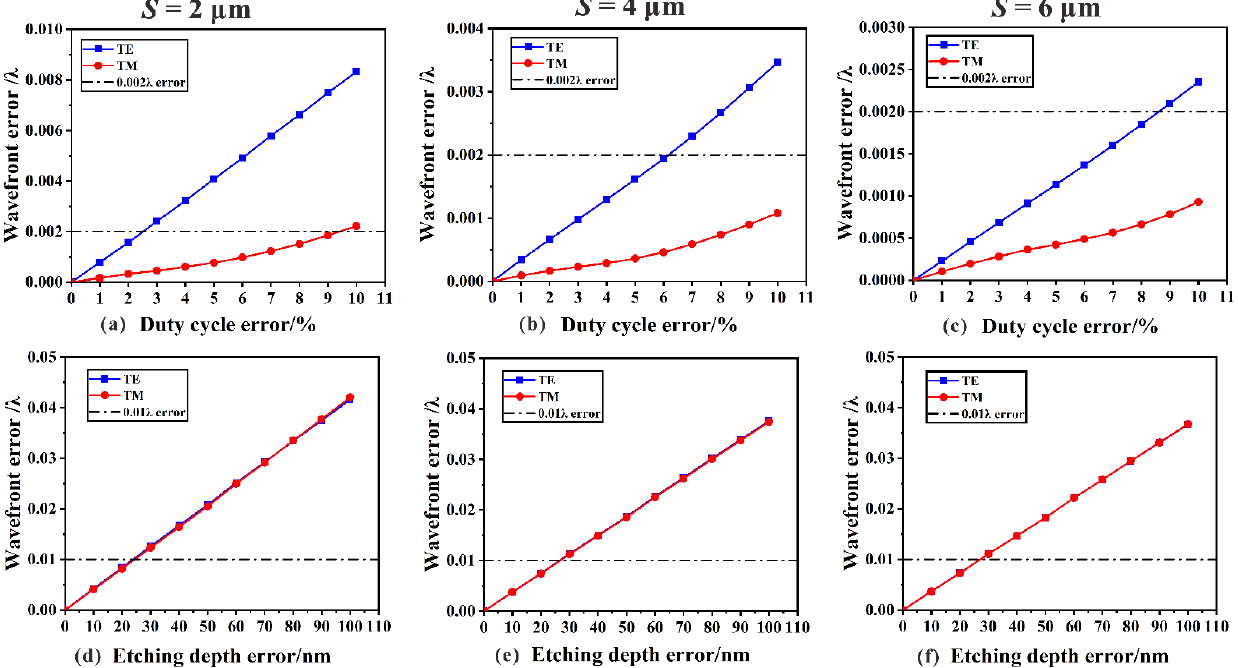
Figure 7. Wavefront deviations caused by errors in the duty cycle ( a – c ) or etching depth ( d – f ) from the geometric reconstruction of 2, 4, and 6 μm gratings. The duty cycle error was less than 10% and the depth error was less than 100 nm. The grating model had an etching depth of 400 nm and a duty cycle of 0.5.